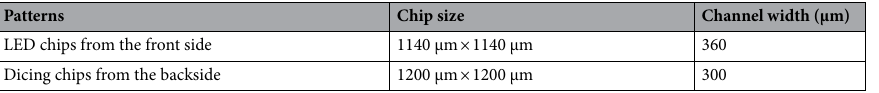
Table 2. Dimensions of the LED chips from the front side and dicing patterns from the backside of the CIC substrate.